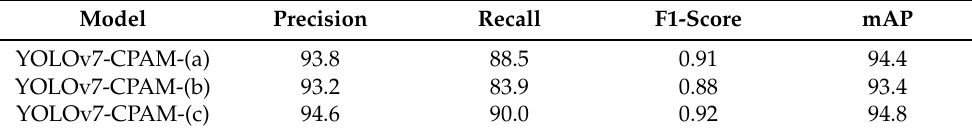
Table 5. The results of CPAM with arranging patches in different spatial orientations.